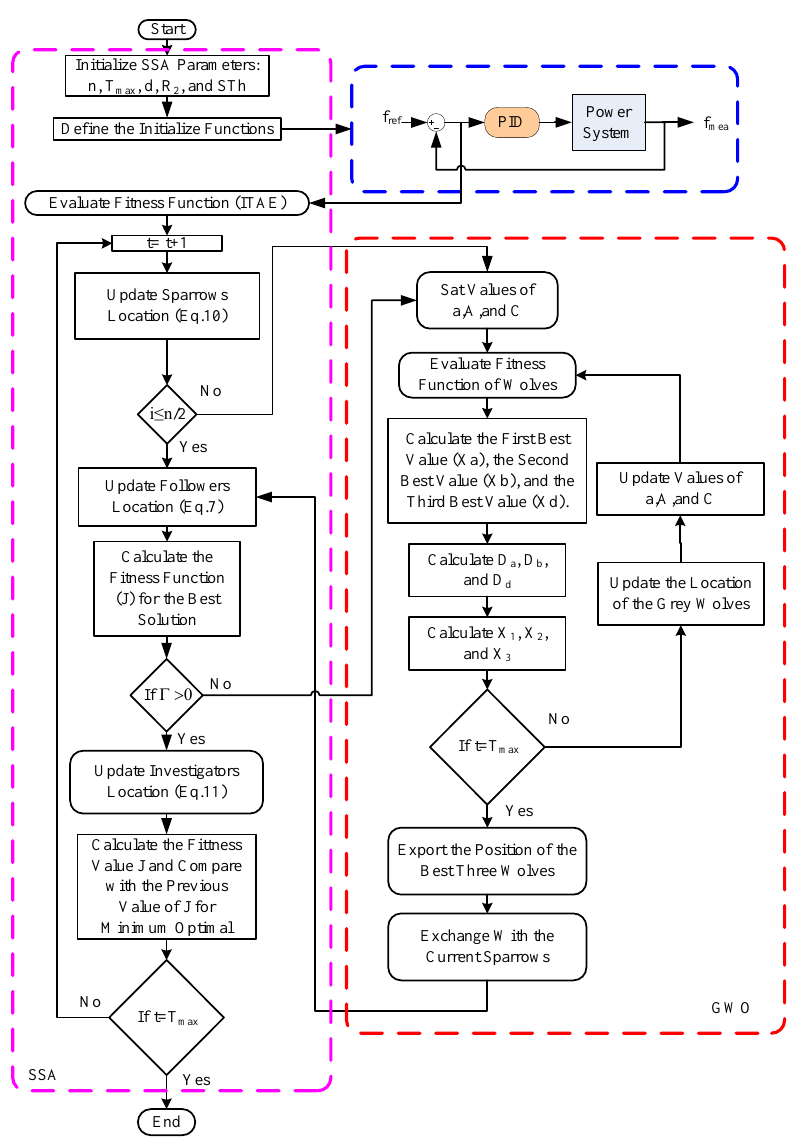
Figure 7. Flow chart of the proposed hybrid SSAGWO algorithm